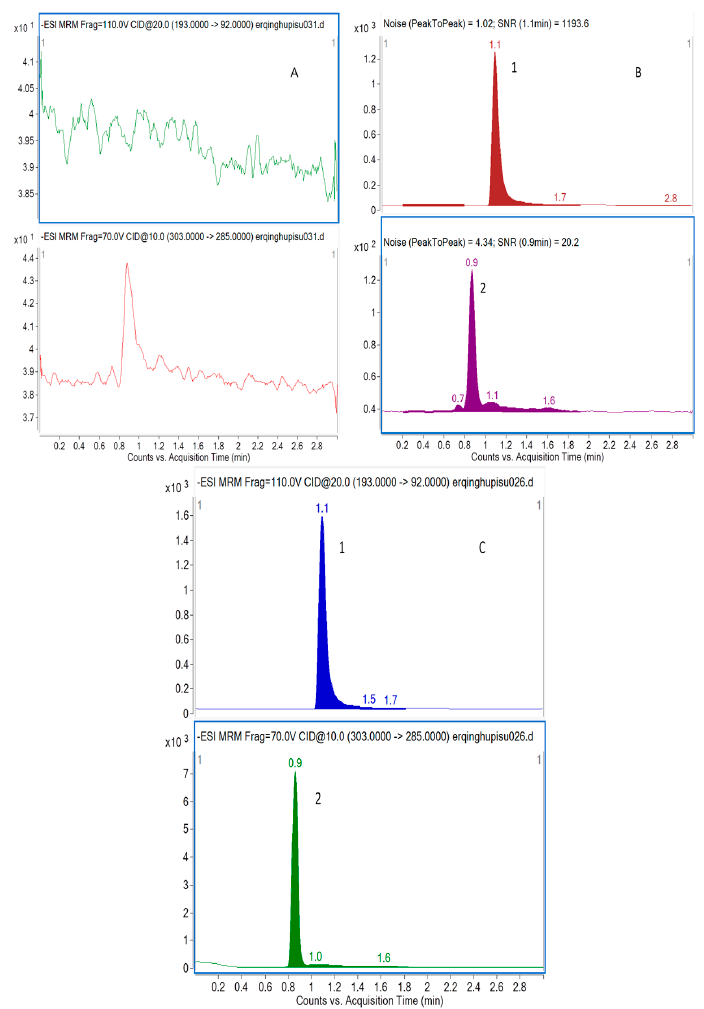
Figure 1. Representative MRM chromatograms of taxifolin (2) and I.S. (1) in rat plasma ( A ) a blank sample (without taxifolin and I.S.); ( B ) LLOQ sample (taxifolin at 5.0 ng/mL and I.S. at 1000 ng/mL);